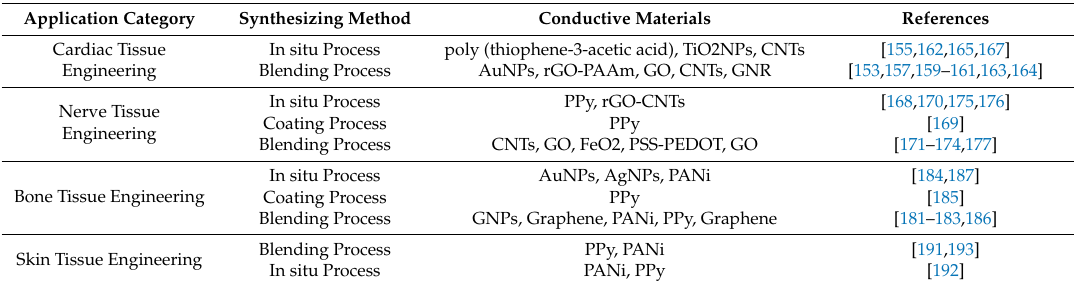
Table 5. References of Tissue-Engineering